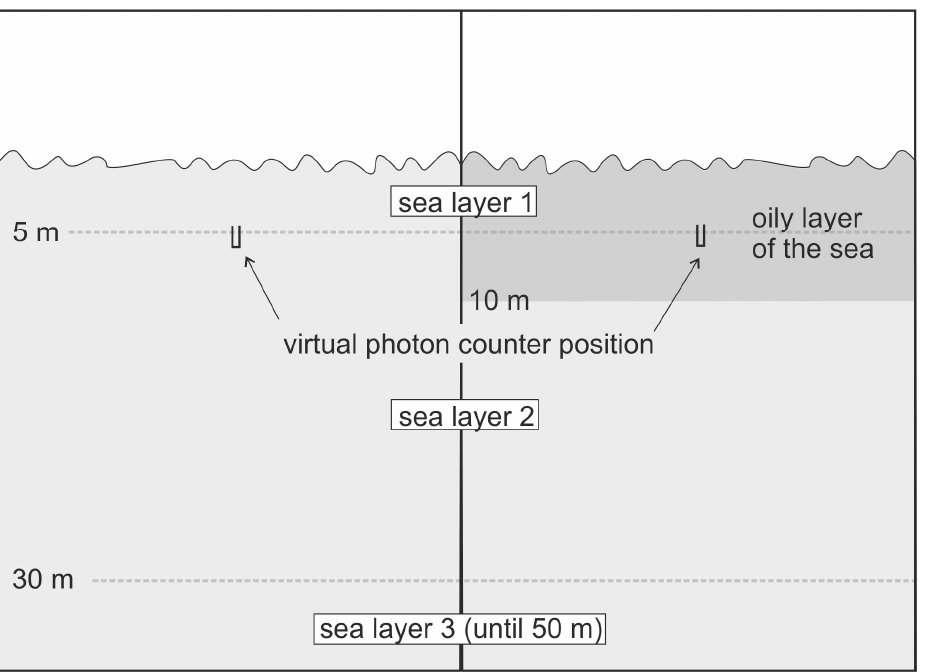
Figure 3. The optical model of the sea basin for eight wavelengths ranging from 412 nm to 676 nm, applied for Monte Carlo simulations of radiative transfer.